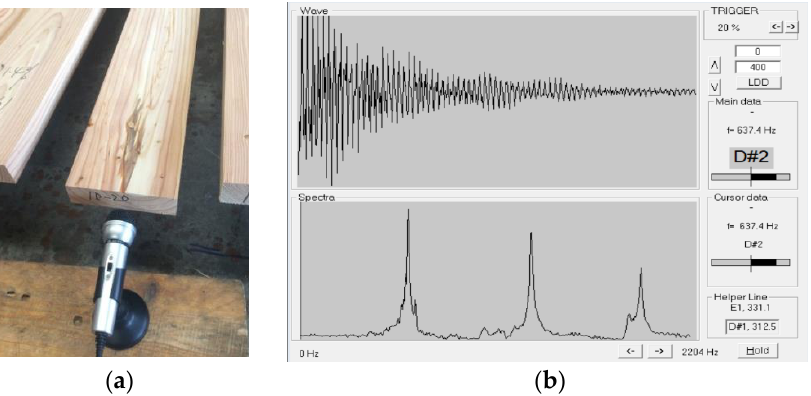
Figure 2. Test set-up ( a ) and screenshot of the software to determine the resonance frequency ( f m ) ( b ). The mean and standard deviation (SD) of the density and MOE Dynamic values for natural and planted larch lumber were determined in R language (Version 3.6.3, R Core Team). Based on the Three Sigma Rule [22], if the absolute difference between the test